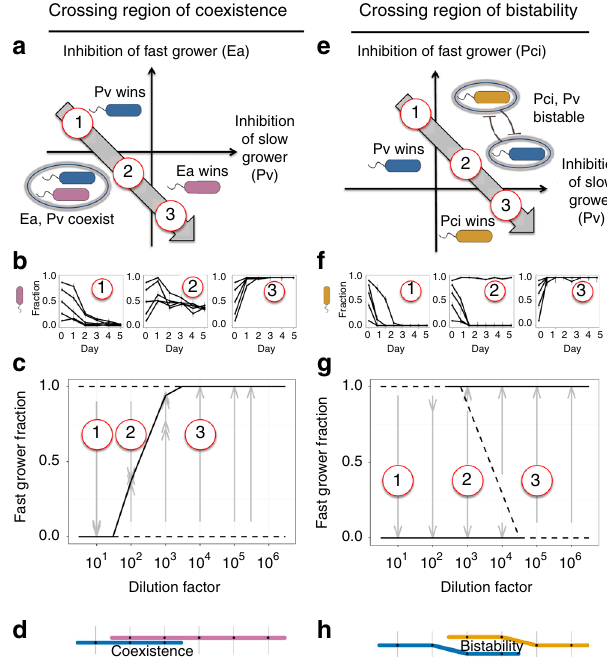
Fig. 3 In pairwise coculture experiments, increasing dilution favors the faster grower. a Experimental results are shown from a coculture experiment with Pv (blue) and Ea (pink). b Left panel: Despite its slow growth rate, Pv excludes faster grower Ea at the lowest dilution factor. Middle panel: Increasing death rate causes the outcomes to traverse the coexistence region of the phase space. Right panel: As predicted, fast- growing Ea dominates at high dilution factor. Error bars are the SD of the beta distribution with Bayes' prior probability (see “ Methods ” ). c An experimental bifurcation diagram shows stable points with a solid line and unstable points with a dashed line. The stable fraction of coexistence shifts in favor of the fast grower as dilution increases. Gray arrows show experimentally measured time trajectories, beginning at the starting fraction and ending at the fi nal fraction. d A “ subway map ” denotes survival/extinction of a species at a particular dilution factor with presence/absence of the species color. e , f Pv outcompeted another fast grower Pci (yellow) at low dilution factors, but the pair became bistable instead of coexisting as dilution increased; the unstable fraction can be seen to shift in favor of the fast grower ( g ). h Two levels in the subway map show bistability. Source data are provided as a Source Data fi